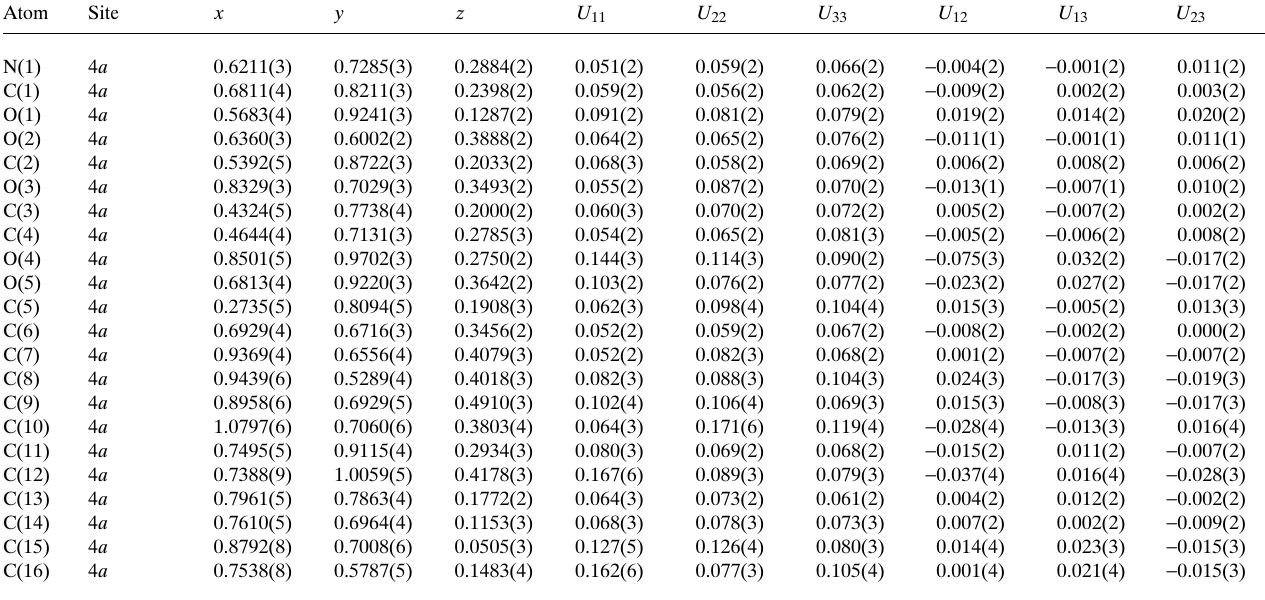
Table 3. Atomic coordinates and displacement parameters (in Å 2 )